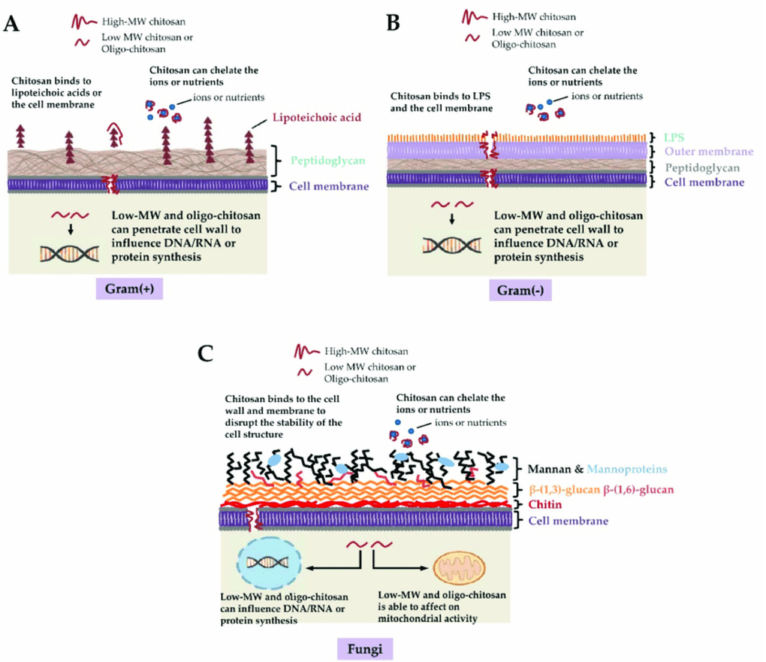
Figure 3. Schematic diagram of bactericidal mechanism of CS on ( A ) Gram-positive bacteria, ( B ) Gram-negative bacteria, and ( C ) fungi [17]. Given the negative charge of teichoic acids in Gram- positive bacteria, lipopolysaccharide (LPS) in Gram-negative bacteria, and phosphorylated mannosyl in fungi, electrostatic interactions occur between positively charged CS and cell surfaces of microor- ganisms. Furthermore, CS chelates environmental ions and nutrients required for bacterial survival. Low-molecular-weight (MW) CS and oligo-CS might affect DNA, RNA, or protein synthesis after passing through cell walls and membranes into cytoplasm. Additionally, low-MW CS and oligo-CS inhibit mitochondrial function and ATP